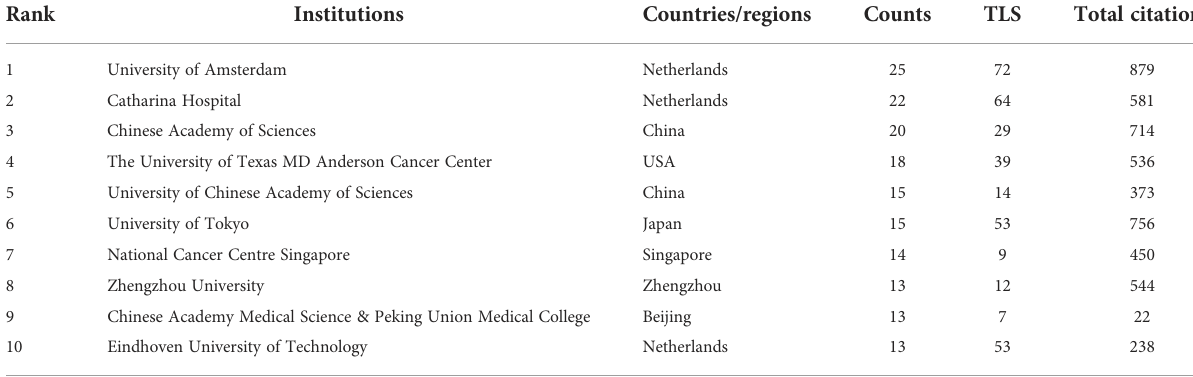
TABLE 2 Top 10 institutes in the publications concerning the research of AI on EC.